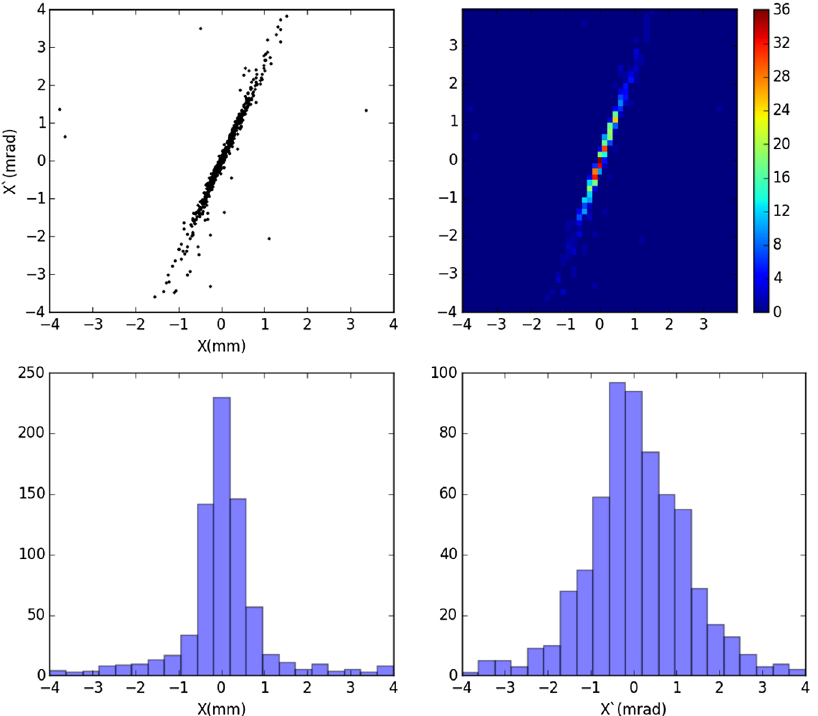
∶ X − X 0 phase space RFQ